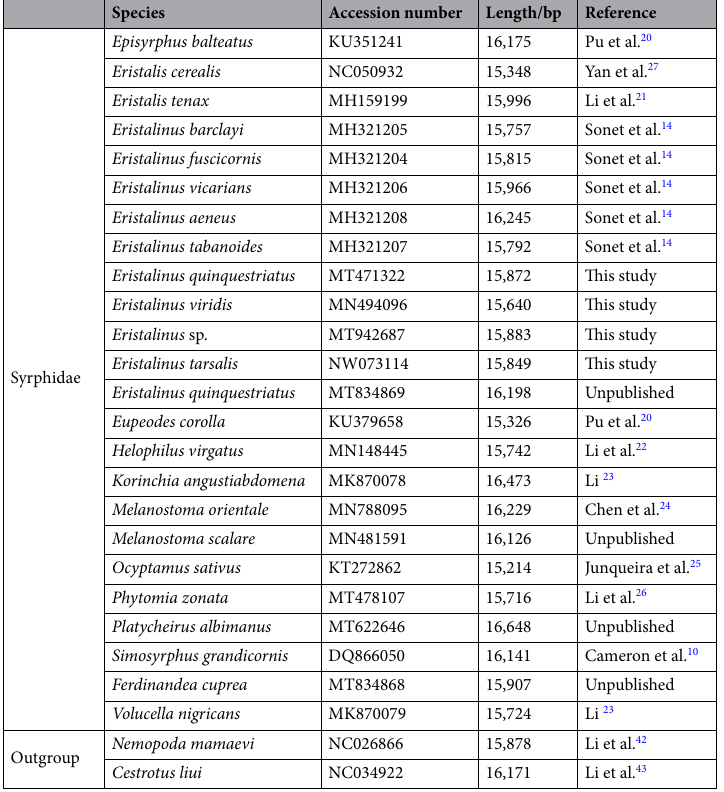
Table 1. Information of complete mitogenomes used for phylogenetic analysis in this